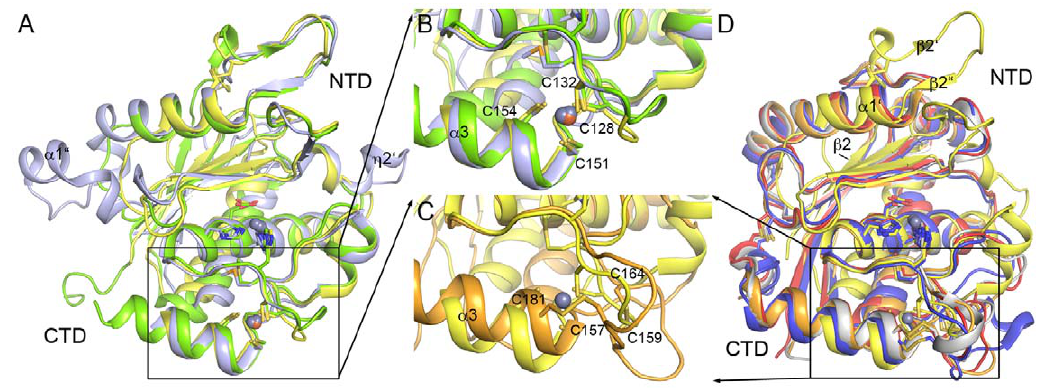
Figure 2. Structural alignment of archaemetzincins and metzincins. (A) Superposition of the three known AmzA structures Af AmzA (yellow), Mk AmzA (green) and Ml AmzA (slate). (B) Close-up view of the Cys 4 zinc finger domains of all three AmzA structures from (A). (D) Superposition of Af AmzA (yellow) with selected metzincins Bap1 (orange), H2-proteinase (grey), acutolysin A (red) and ADAM33 (blue). In place of a Cys 4 zinc finger found in Af AmzA (yellow), the superposed metzincins exhibit two disulfide bonds as shown in (C) using the example of Bap1 (orange). Individual cysteine residues are labeled in accordance with the amino acid sequence of Af AmzA (yellow) in (B) and Bap1 (orange) in (C), respectively. Important secondary structure elements are labeled.